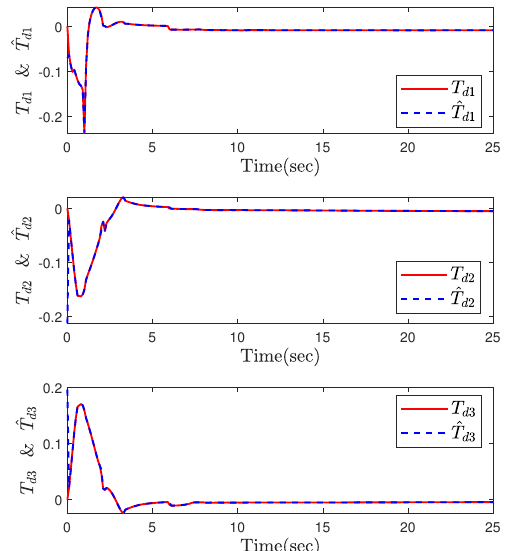
Figure 16. The total disturbance and its estimation in Part